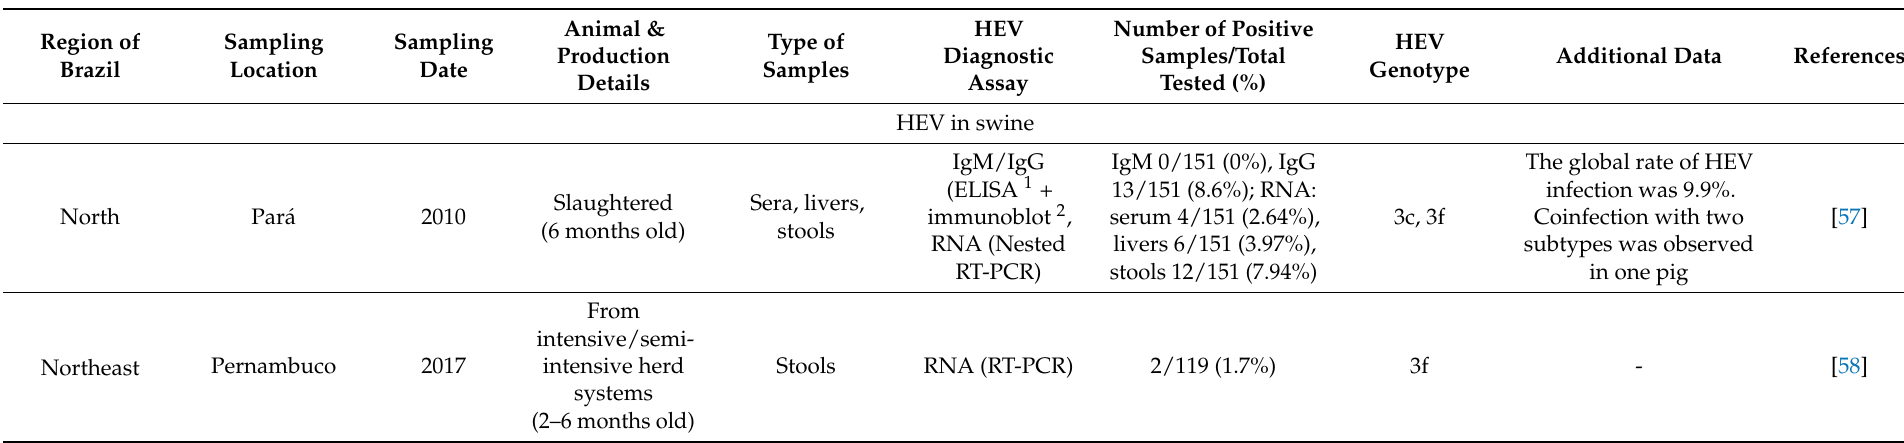
Table 2. HEV in swine and animal products,